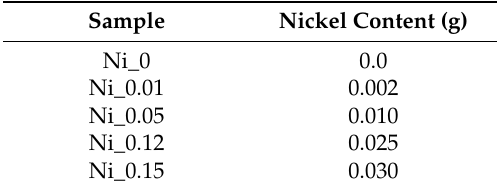
Table 4. Sample labeling and nickel content in the samples.